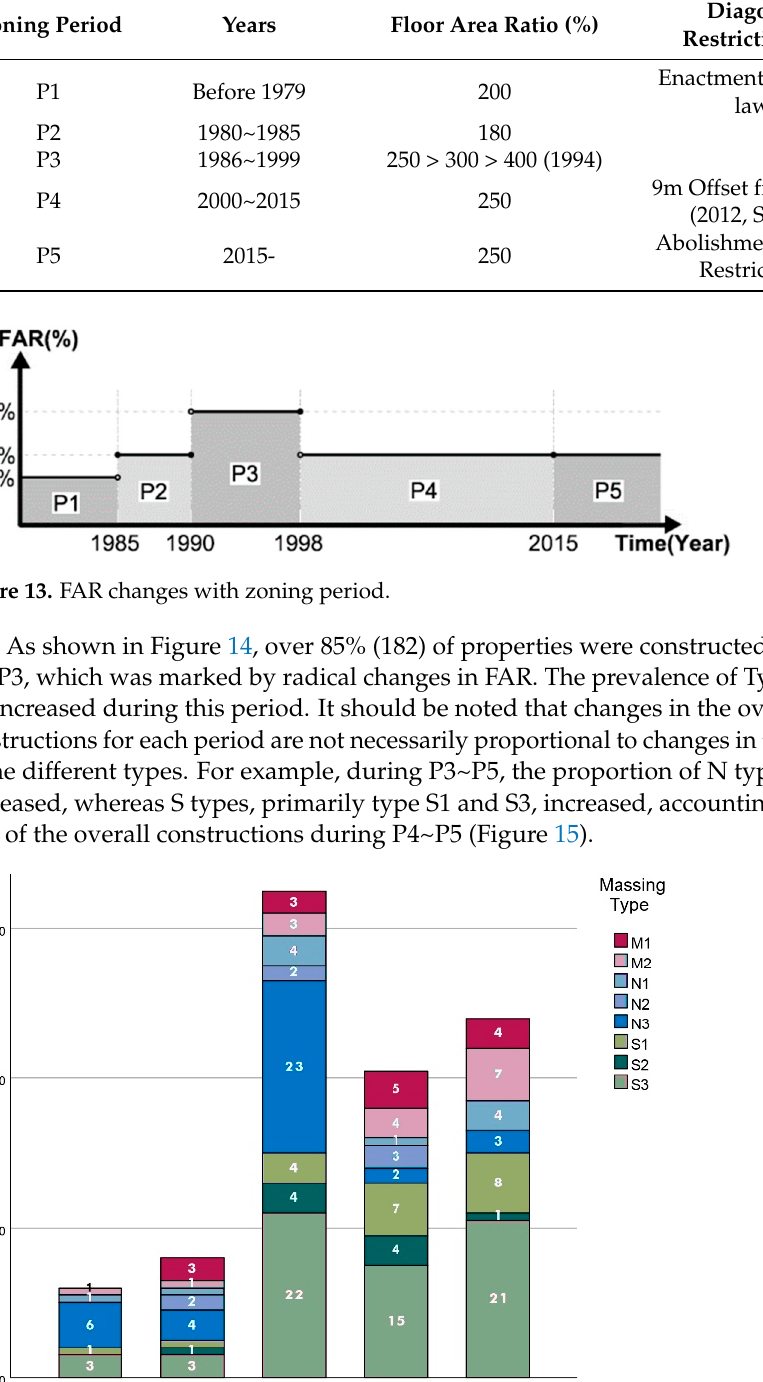
Figure 15. Percentage of each type per zoning period. It is evident that the types exhibiting ineffective applicability of the Diagonal Plane Restrictions (S1 and S3) are on the rise. By contrast, there has been a rapid decline in N types that would benefit most from the restrictions, which clearly illustrates the policy’s limitations. Although further research is needed to quantify the causes, the results indicate that fewer buildings have been constructed with south-facing units or habitable spaces in recent years. This appears abnormal, given Korea’s cultural preference for southern expo- sures. Further, since the sample blocks are located near the boundary of General Residen- tial Districts, which have a high concentration of commercial uses, the results could also suggest changes to the use of buildings ranging from residential to commercial. A detailed discussion of the interrelation will be presented in the following subsection. 4.2. Primary Uses and Effectiveness of the Regulation The previous binary analysis result showed that primary use is another critical factor to consider. Thus, we continued with further descriptive analysis since the specific uses could provide additional information about the regulations’ applicability. As shown in Figure 16, 52% (109) of the sample buildings’ primary uses were for non-residential pur-